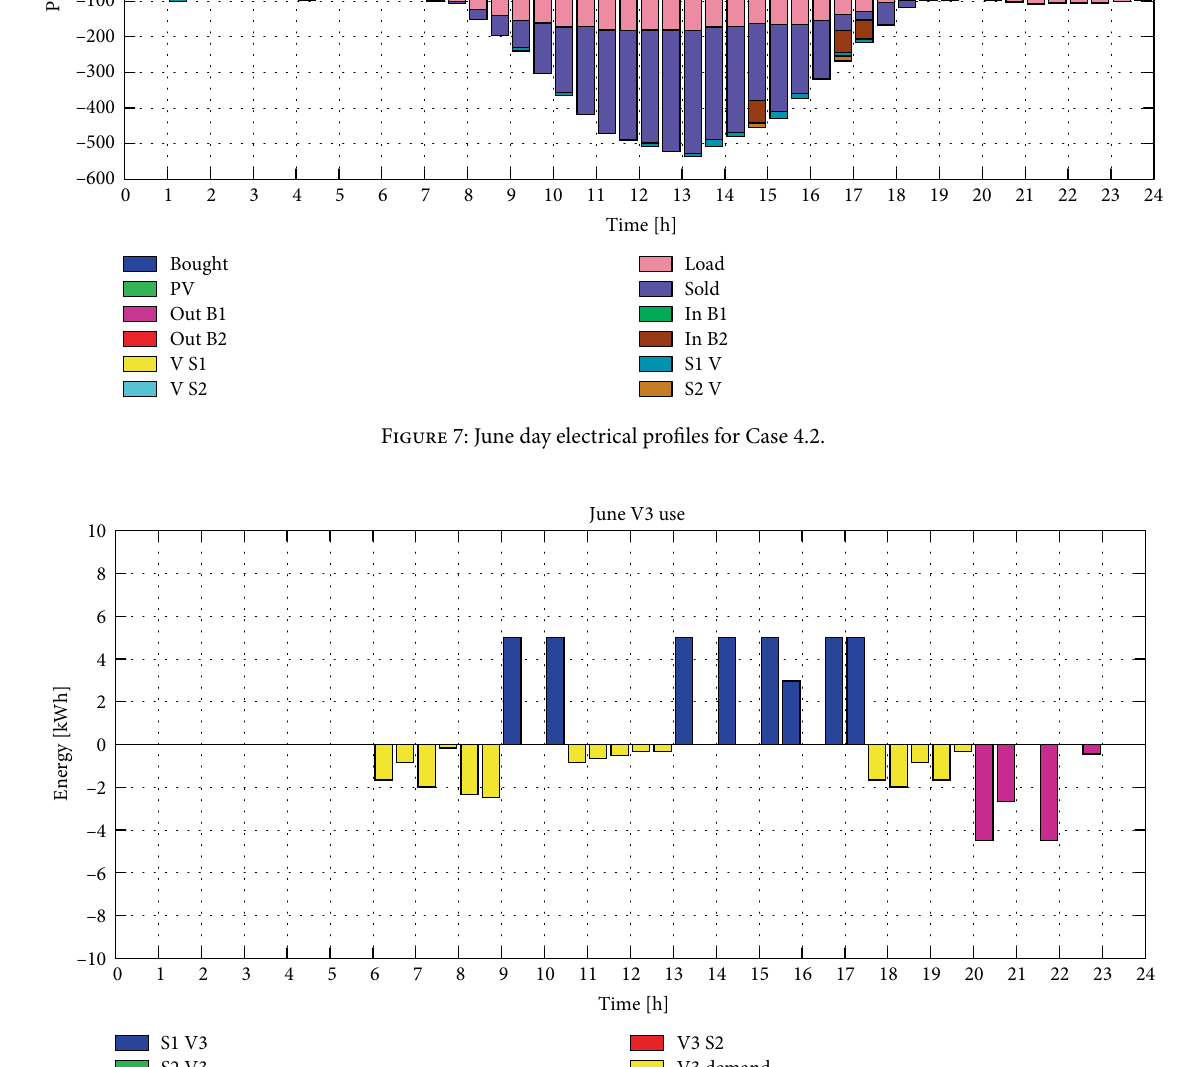
Figure 8: June day electrical profiles for one “Nissan Leaf” in Case